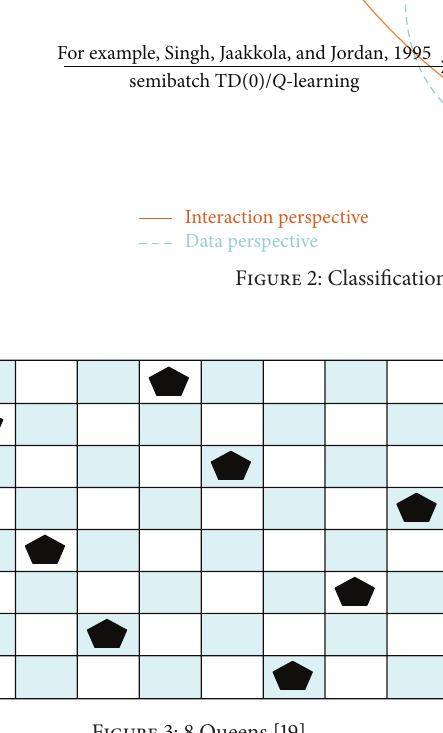
Figure 3: 8 Queens